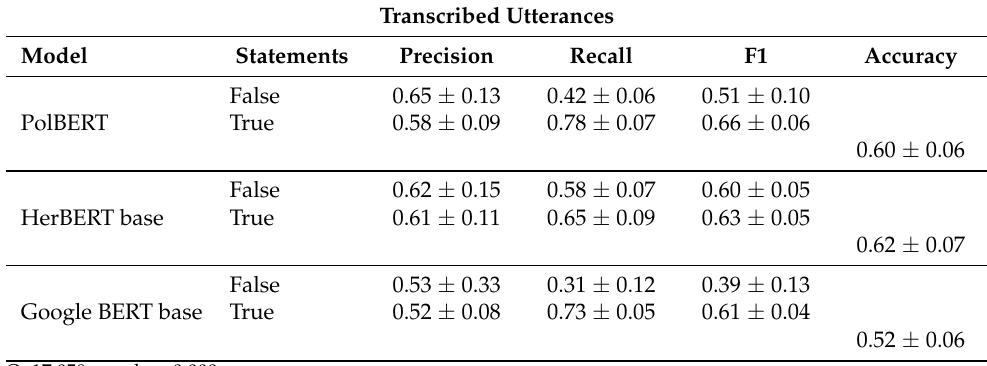
Table 3. Results of BERT models for transcribed utterances ( ± cross-validation standard deviations).